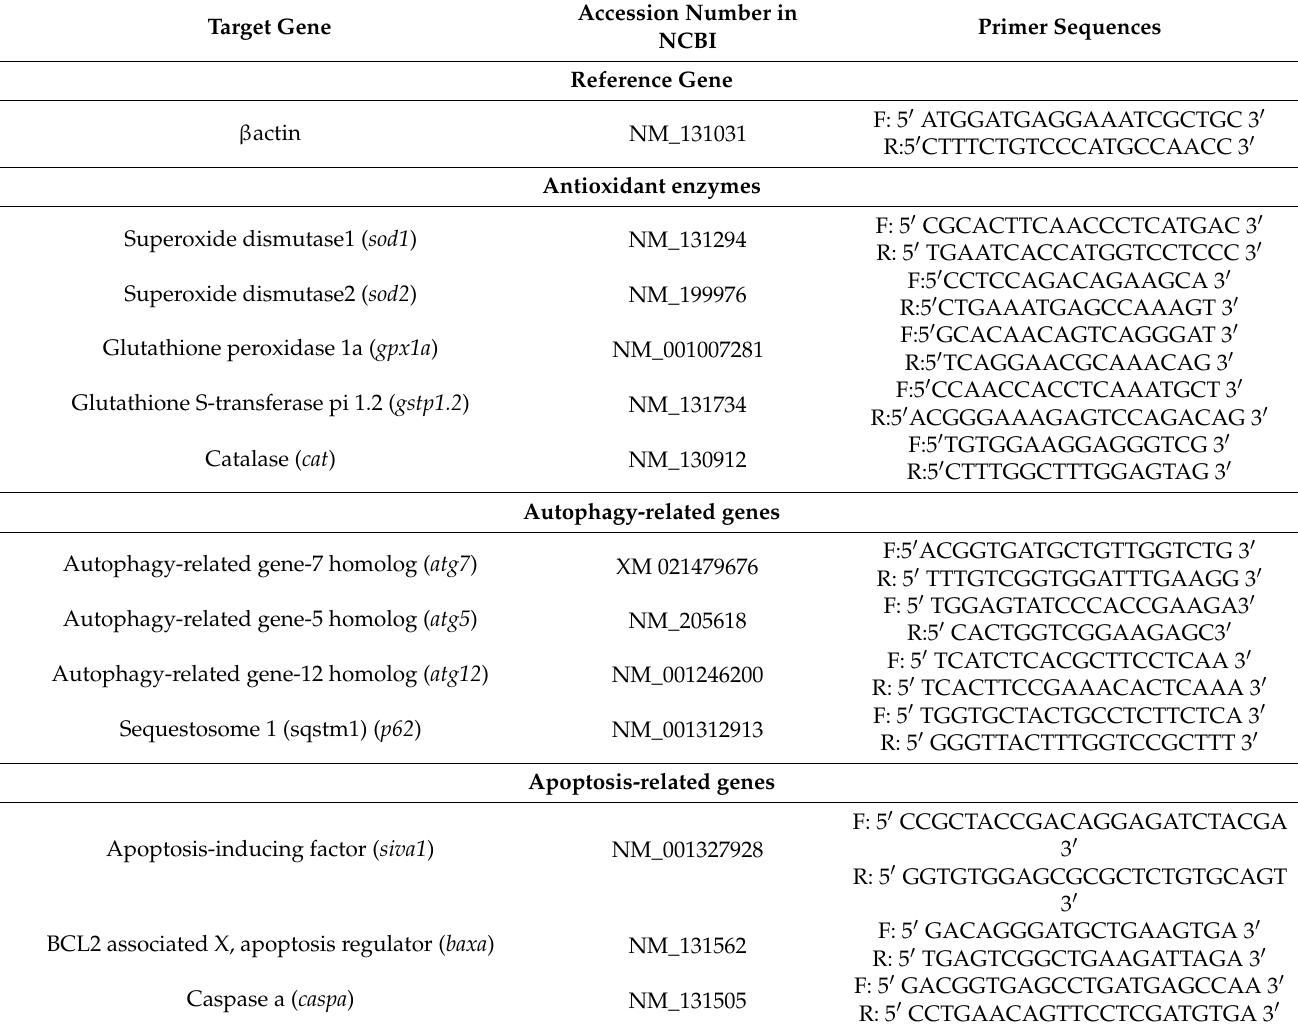
Table 1. Target genes, accession number, and primer sequences for quantitative real-time PCR